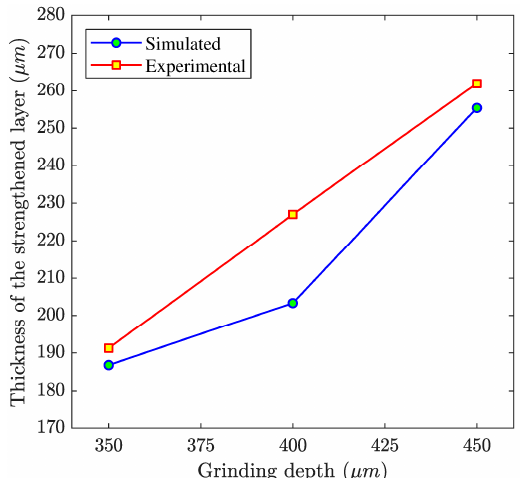
Figure 7. The thickness of the strengthened layer under different grinding depths.